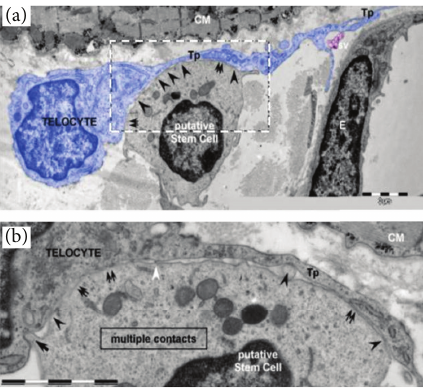
Figure 6: Electron microscopy pictures of telocyte-putative stem cell junctions observed in the human heart. The picture describes the contact point (arrowheads) among a putative stem cell and a telocyte (blue color). Broader planar contacts (double arrows) can be observed. (a) The average distance between the putative stem cell and plasma membranes of telopode, Tp, is 43 ± 20.3 nm (min: 20.3 nm; max: 90.6 nm). E, endothelial cell; sv, shed vesicles; CM, cardiomyocyte. (b) High magnification on a consecutive ultrathin region of the rectangular site indicated in (a) describes the geometry of the 8 𝜇 m long heterocellular connections; plasma membranes of tight-fitting apposed sectors (double arrows); dot contacts (arrow- heads) change with planar contacts. A small cellular projection of putative stem cell (arrow) is located on a small recess of the telocyte. Thick nanostructures (15–20 nm) can be found with connection of the plasma membranes of the cells (white arrowheads). Bars represent 2 𝜇 m. Modified with permission from Creative Commons Attribution License